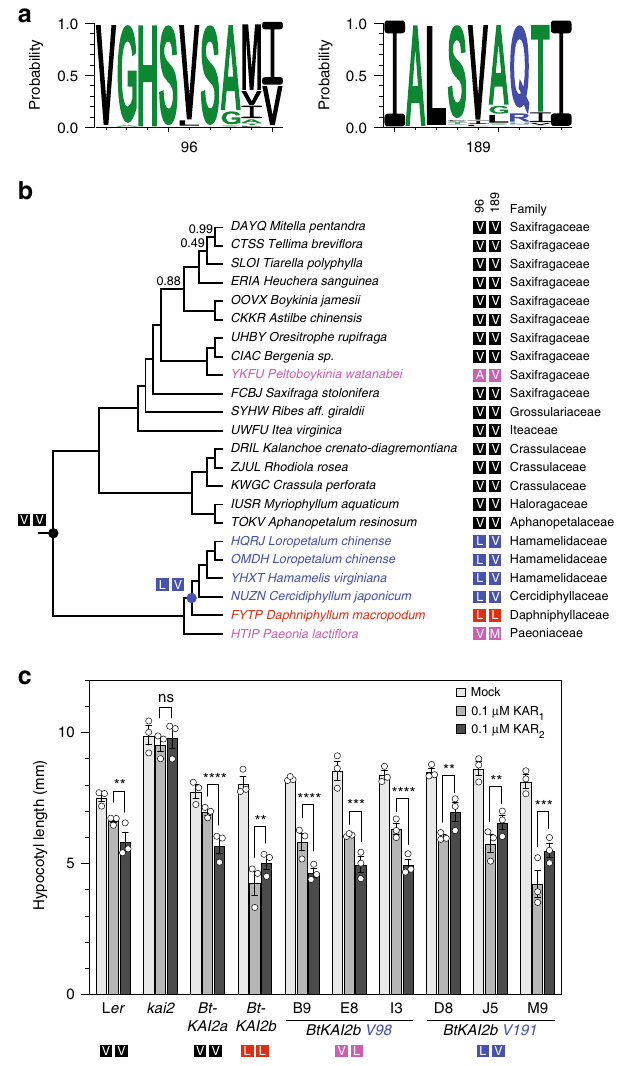
Fig. 5 Diversity at positions 96 and 189 in KAI2 homologues across angiosperms. a Sequence logos generated from 476 aligned KAI2 homologues sampled from eudicots, monocots and magnoliids and centred on position 96 (left) and 189 (right). b Species tree of the Saxifragales based upon 410 single-copy nuclear genes estimated using the ASTRAL gene tree method 50 . Branch support values are shown only where <1. The four-letter taxon pre fi x corresponds to the 1000 Plant Transcriptomes project Sample ID. Taxa are highlighted by colour according to identity of amino acids of KAI2 orthologues at positions 96 and 189, respectively: black, VV; blue, LV; red, LL; magenta, other. Postulated ancestral identities at speci fi c nodes are indicated with fi lled circles. c Hypocotyl elongation responses to karrikins in three independent transgenic lines homozygous for GFP-BtKAI2a L98;V191 and three lines for GFP-BtKAI2b V98;L191 . Data shown are a summary of three experimental replicates performed on separate occasions, each comprising ~20 seedlings per genotype/treatment combination. Data from each replicate are presented in Supplementary Fig. 13. Error bars are SE, n = 3 experimental replicates; each dot corresponds to the mean value derived from each replicate. Asterisks denote signi fi cant differences: * P < 0.05, ** P < 0.01, *** P < 0.001, **** P < 0.0001 (linear mixed model with experimental replicate as a random effect; speci fi c pairwise comparisons using Tukey ’ s HSD correction). Source data are provided as a Source Data fi